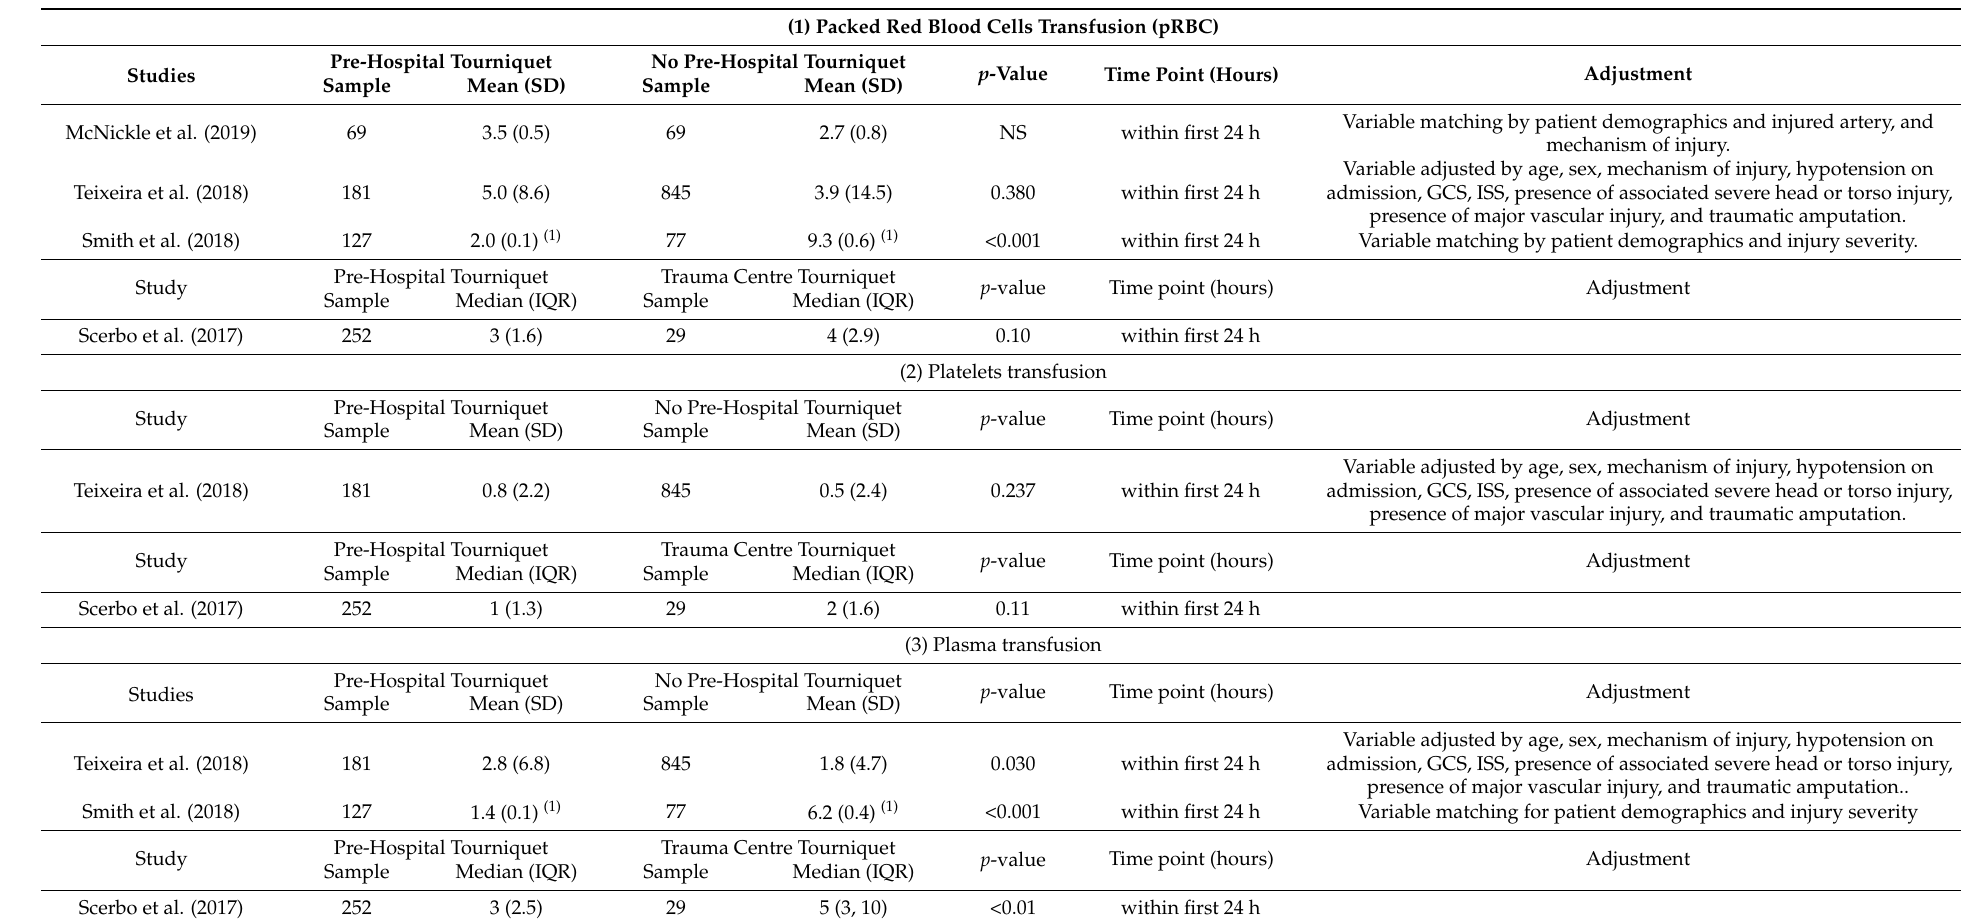
Table 4. Transfusion of blood